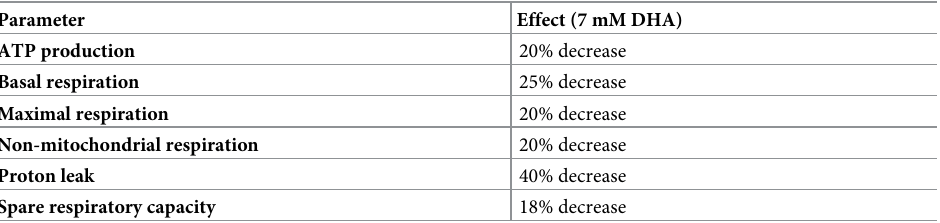
Table 3. Flux analysis of oxidative phosphorylation in DHA-exposed HepG3 cells.